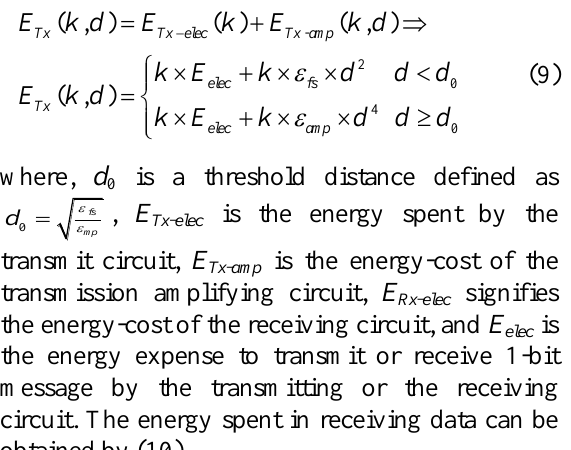
Figure 4. Final WSN design using GA.